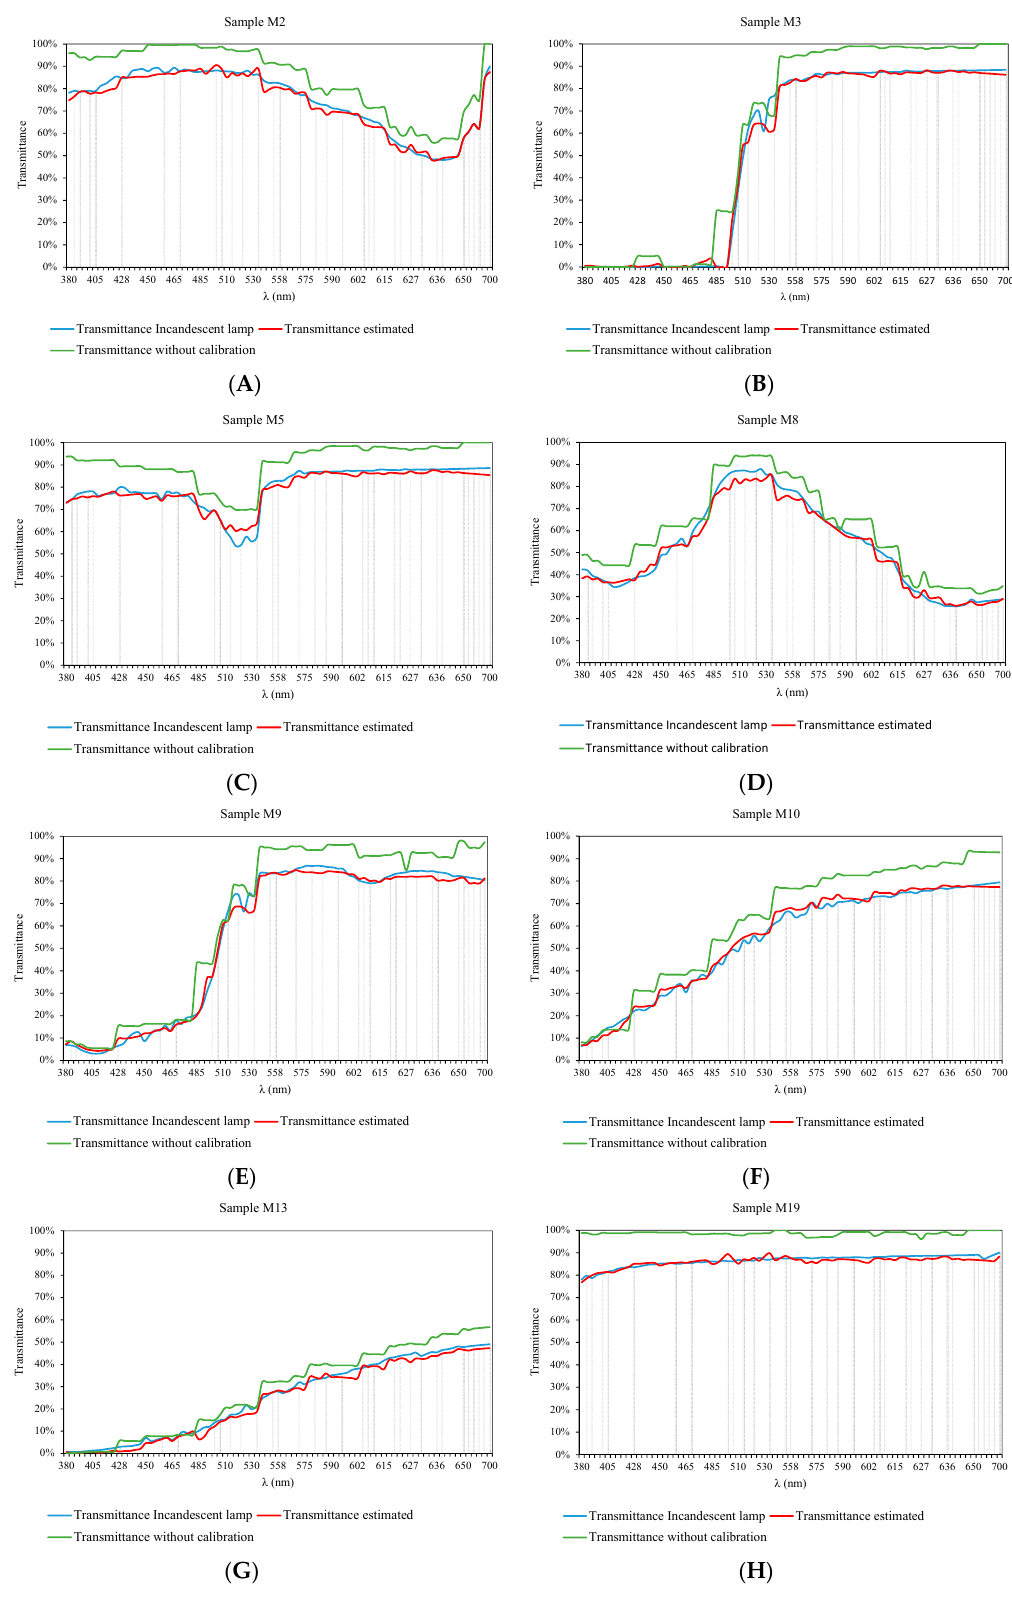
Figure 20. Comparative results of the transmittance values, before (green) and after (red) the calibration process for the following samples: ( A ) M2, ( B ) M3, ( C ) M5, ( D ) M8, ( E ) M9, ( F ) M10, ( G ) M13 and ( H ) M19.